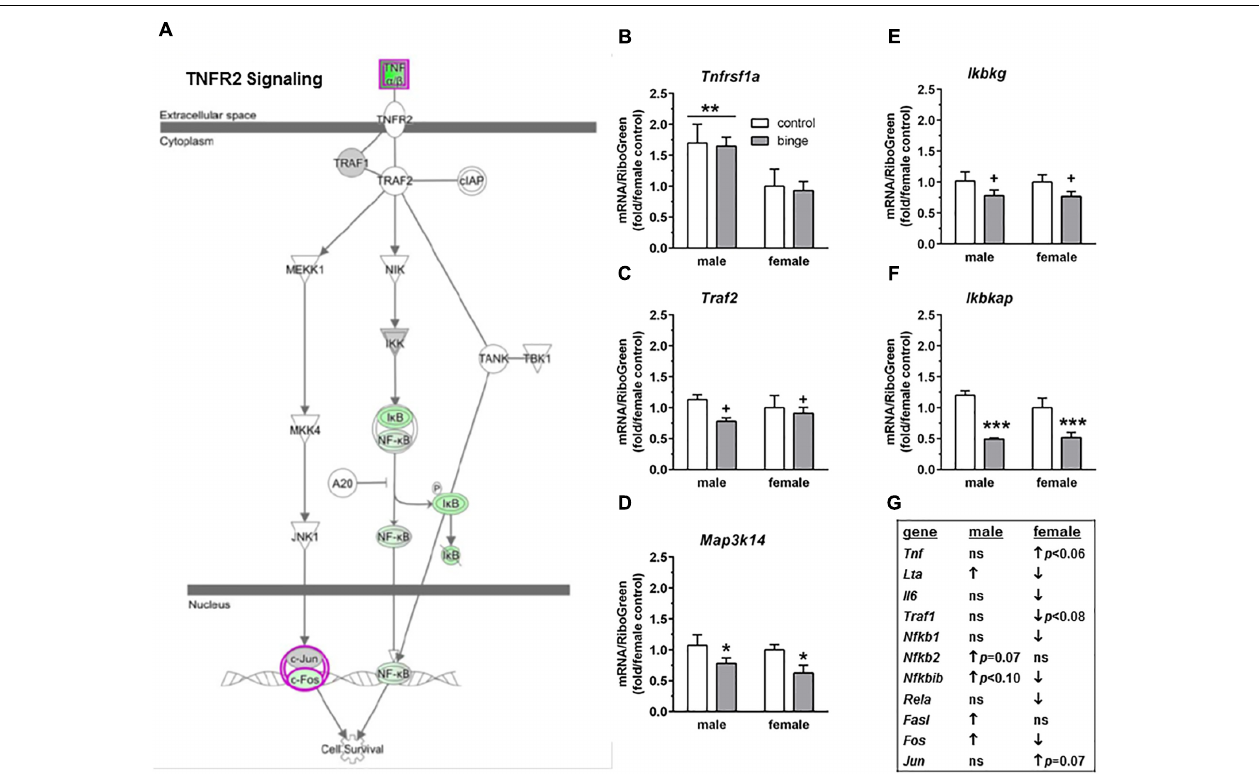
FIGURE 5 | Simplified tumor necrosis factor receptor 2 (TNFR2) signaling pathway highlights genes influenced by repeated binge drinking in male and female mice. This canonical pathway was identified by IPA as regulated by binge drinking in both males and females. (A) Depicts the TNFR2 signaling pathway and highlights genes regulated by binge drinking in females (pink for up-regulation, green for down-regulation). (B–F) Depict qRT-PCR results. Expression of Tnfrsf1a ( B which encodes TNFR1 and forms a heterocomplex with TNFR2) was significantly higher in males vs. females. However, Map3k14 ( D encodes NIK) and Ikbkap ( F encodes IKAP) expression was significantly decreased by binge drinking in both males and females, whereas expression of Traf2 ( C encodes TRAF2) and Ikbkg ( E encodes IKK- γ ) trended toward a decrease by binge drinking in both sexes. Values are the mean ± SEM for 4/sex/treatment. + p < 0.09, ∗ p < 0.05, ∗∗∗ p < 0.001 for main effect of treatment, ∗∗ p < 0.01 for main effect of sex (over horizontal line). (G) Shows significant regulation by binge drinking of select genes from the qPCR array analysis in male and female mice that are pertinent to the TNFR2 signaling cascade depicted in (A) ( ↑ for up-regulation, ↓ for down regulation; p < 0.05 at a minimum). For statistical trends, the p -values are provided. Tnfrsf1a (tumor necrosis factor receptor superfamily, member 1a) encodes TNFR1, which is a member of the TNF receptor superfamily of proteins. Traf2 (TNF receptor-associated factor 2) encodes TRAF2. Map3k14 (mitogen-activated protein kinase kinase kinase 14) encodes NIK. Ikbkg (inhibitor of kappaB kinase gamma) encodes IKK- γ or NEMO, which is one of three subunits that forms the I κ B kinase (IKK) enzyme complex. Ikbkap (inhibitor of kappa light polypeptide gene enhancer in B-cells, kinase complex-associated protein) encodes